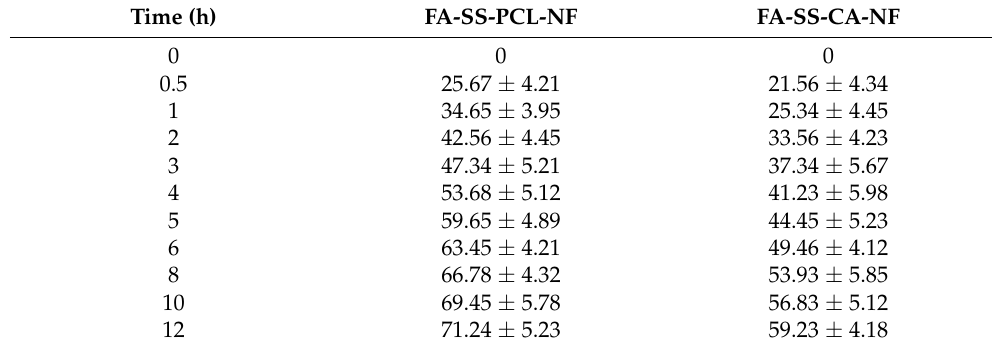
Table 3. Cumulative (%) drug release data of optimized formulations (mean ±